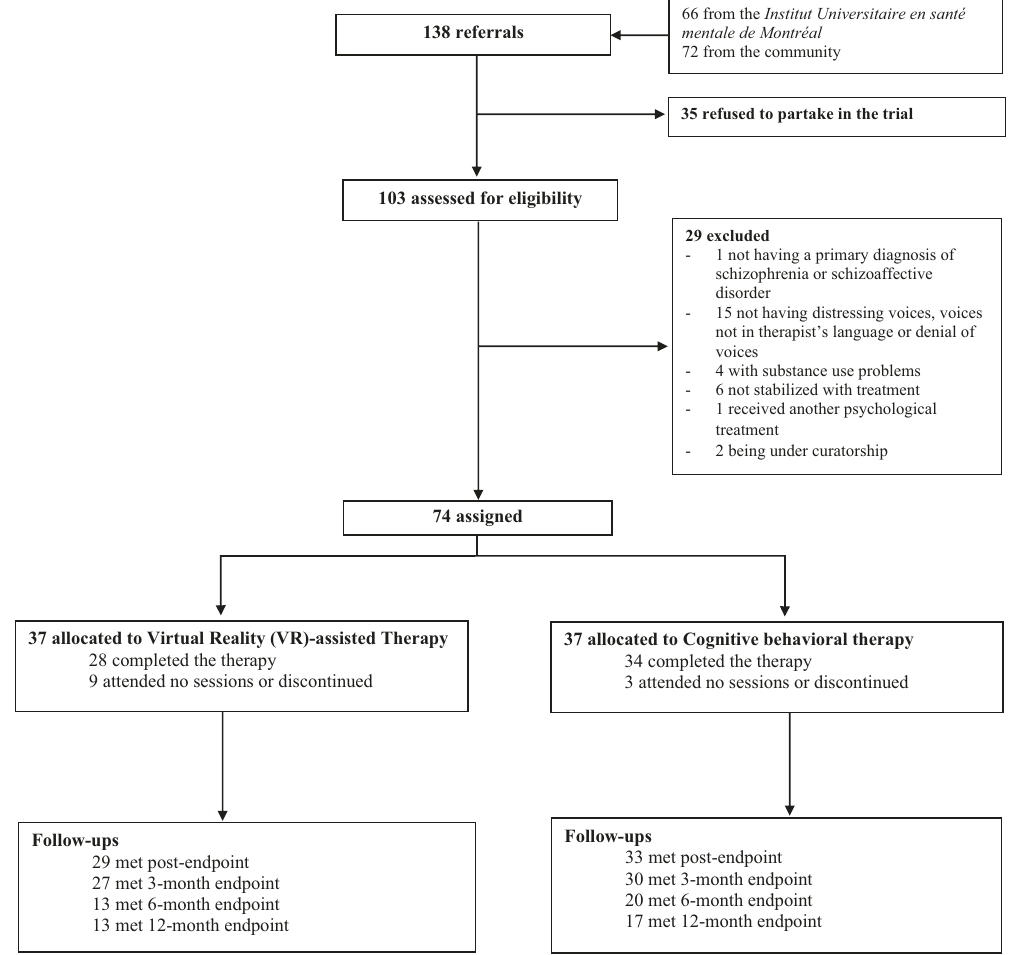
Fig. 1 Trial pro fi le of patients who received virtual reality (VR)-assisted therapy or cognitive – behavioral therapy. There were 138 referrals provided by clinical teams and the community, of whom 74 were eligible and randomized to either one of the